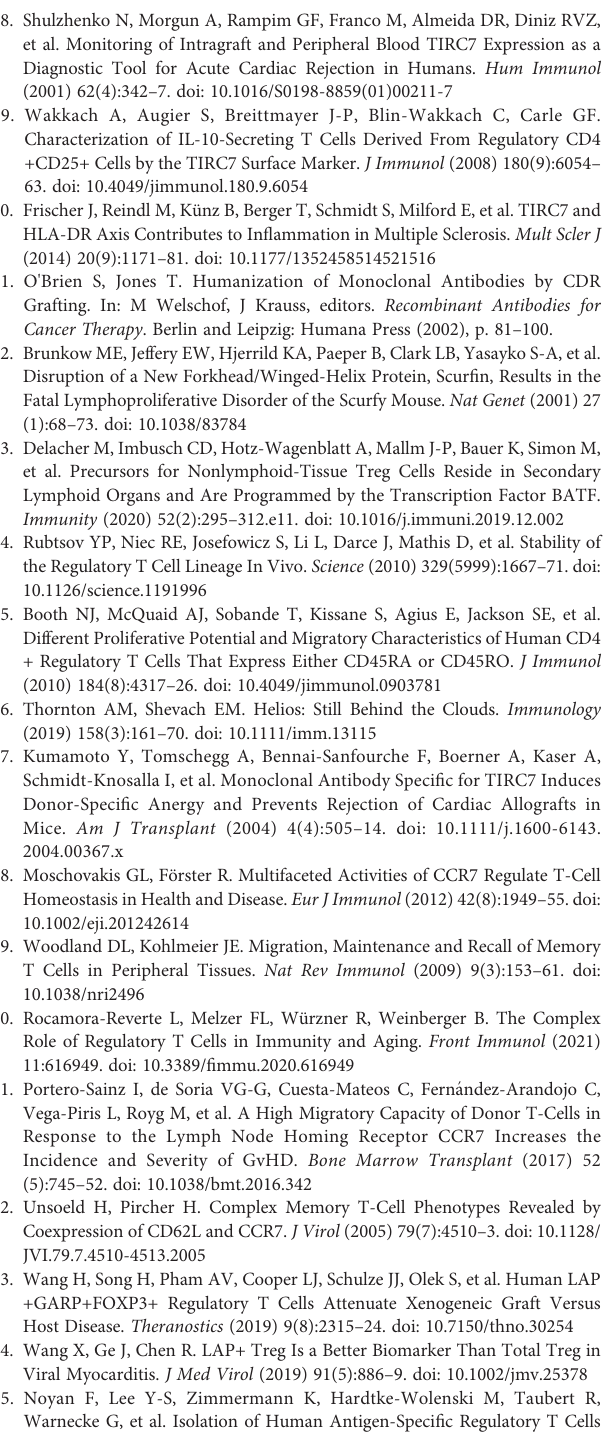
Supplementary Figure 3 | Speci fi city of TIRC7 antibody. (A) TIRC7 antibody detected speci fi cally recombinant TIRC7 protein only in COS7 transfected cells. (B) . TIRC7 protein was not detected in TIRC7 knockout mice (-/-) splenocytes in comparison to wild type (+/+) using TIRC7 mAb. (C) Biacore SPR analysis performed in varying concentrations to determine the kinetic constants or absorption effects as shown for